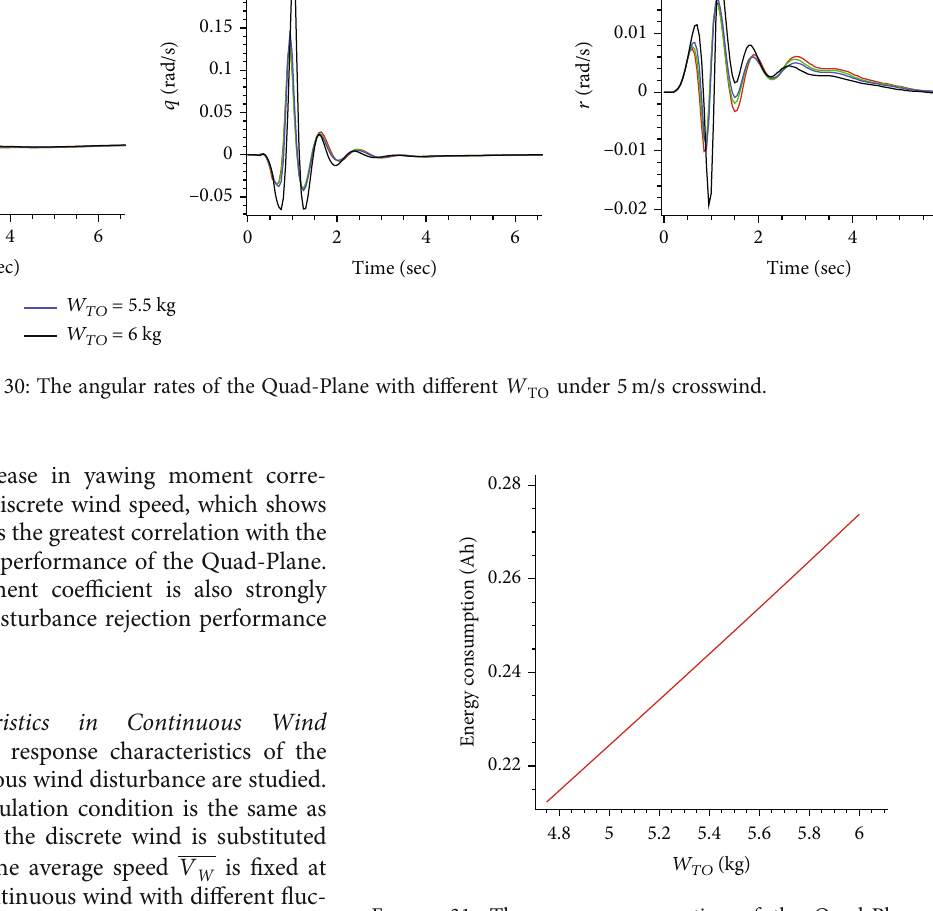
Figure 31: The energy consumption of the Quad-Plane with di ff erent W TO under 5.6m/s wind disturbance in 30s.